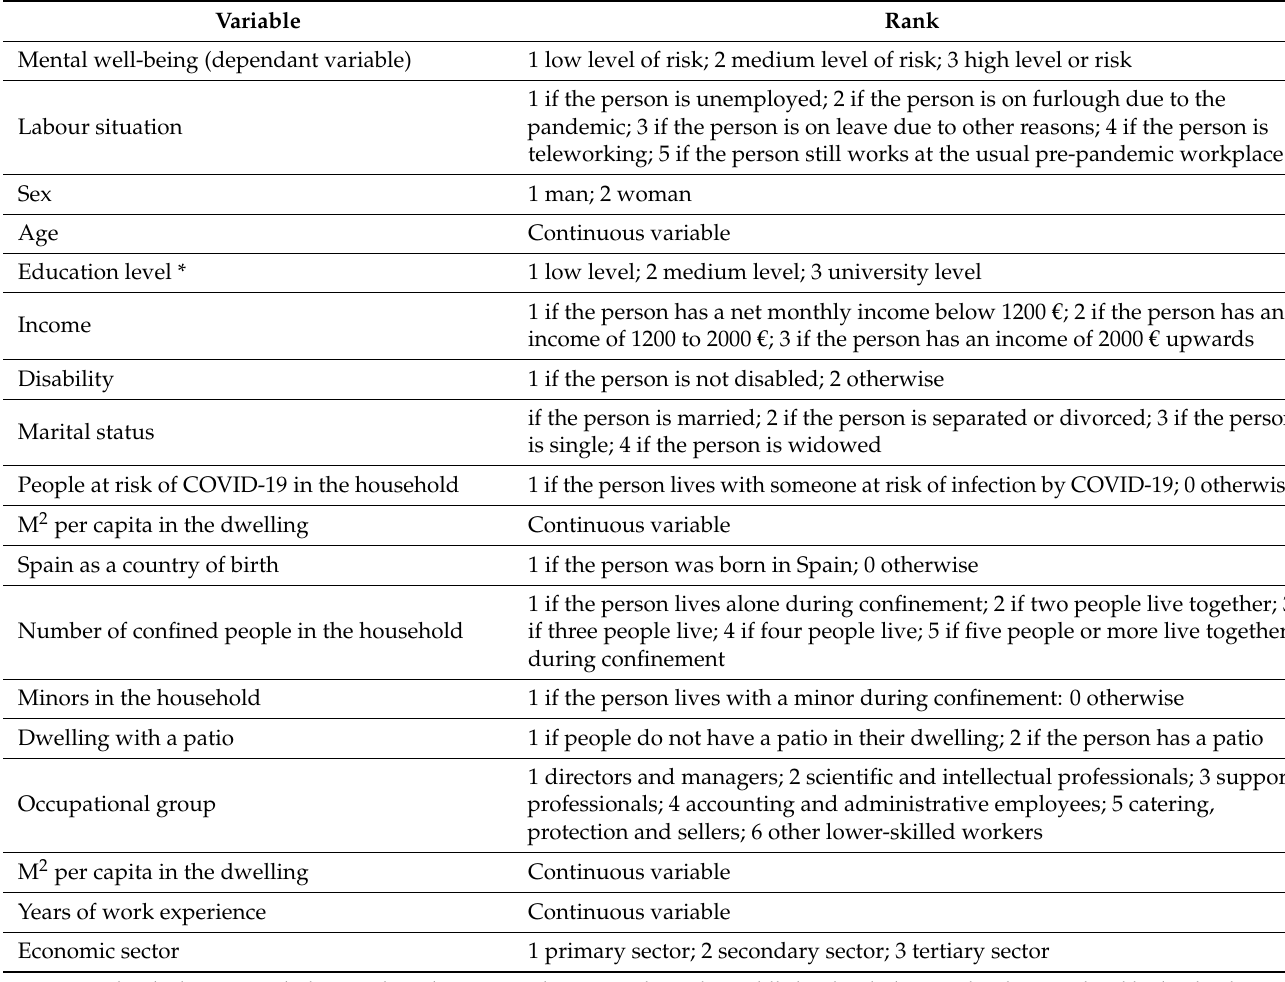
Table 1. Variables included in the